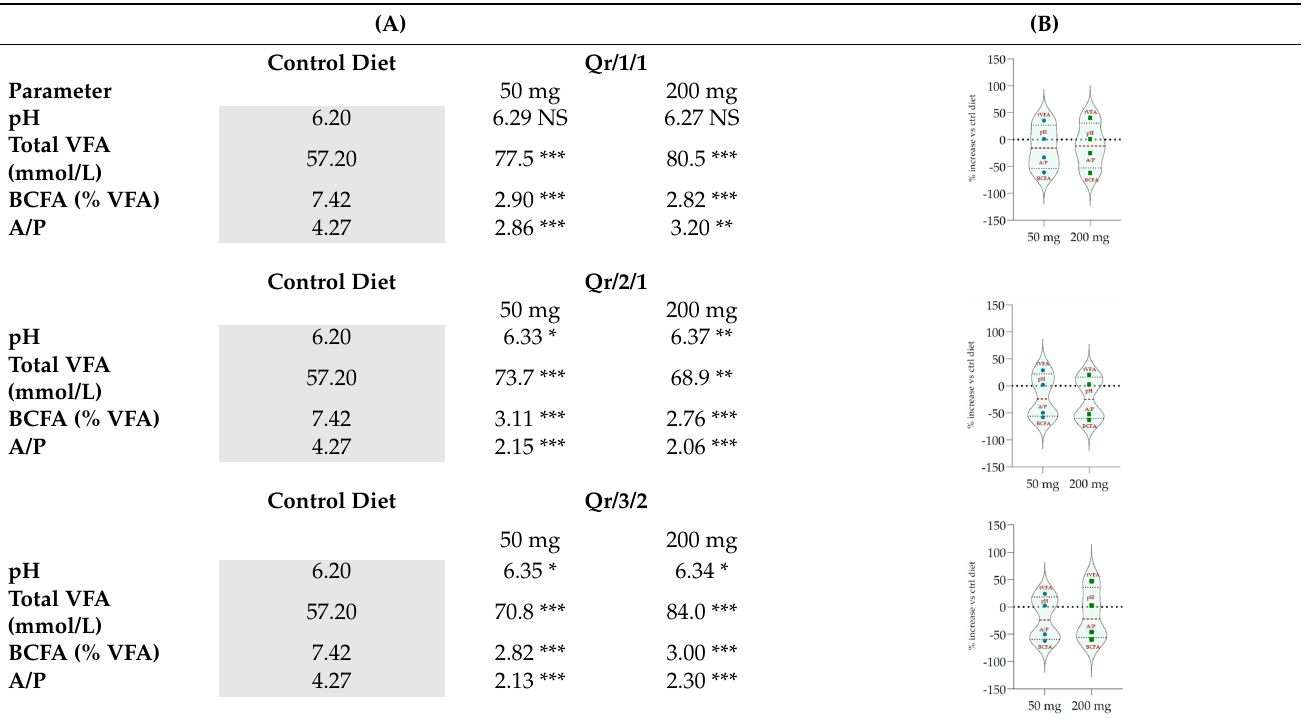
Table 4. ( A ) Effects of Q. robur L. extracts at different doses (50 mg and 200 mg) on fermentation end products after 120 h of incubation. Total VFAs: total volatile fatty acid (acetate + propionate + butyrate + iso-butyrate + valerate + iso-valerate); BCFA: branched-chain fatty acid proportion [(iso- butyrate + iso-valerate)/tVFA] × 100; A/P: acetate/propionate ratio. * p < 0.05, ** p < 0.01 and *** p < 0.001. NS: not significant, ( B ) ViolinPlot of the percentage increase or decrease of end products plotted for different tested dose level ( ● 50 mg and ■ 200 mg) vs. % in the control diet.